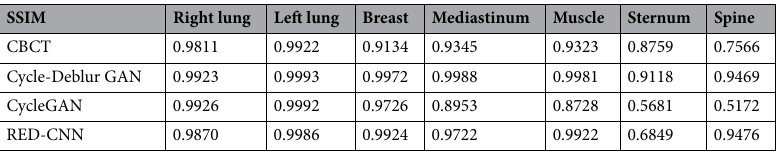
Table 4. SSIM comparison of different models at different sites.